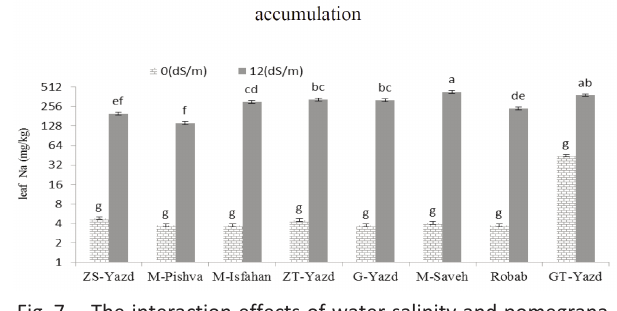
aFig. 7 ­ The interaction effects of water salinity and pomegrana­ te cultivars on leaf sodium accumulation.